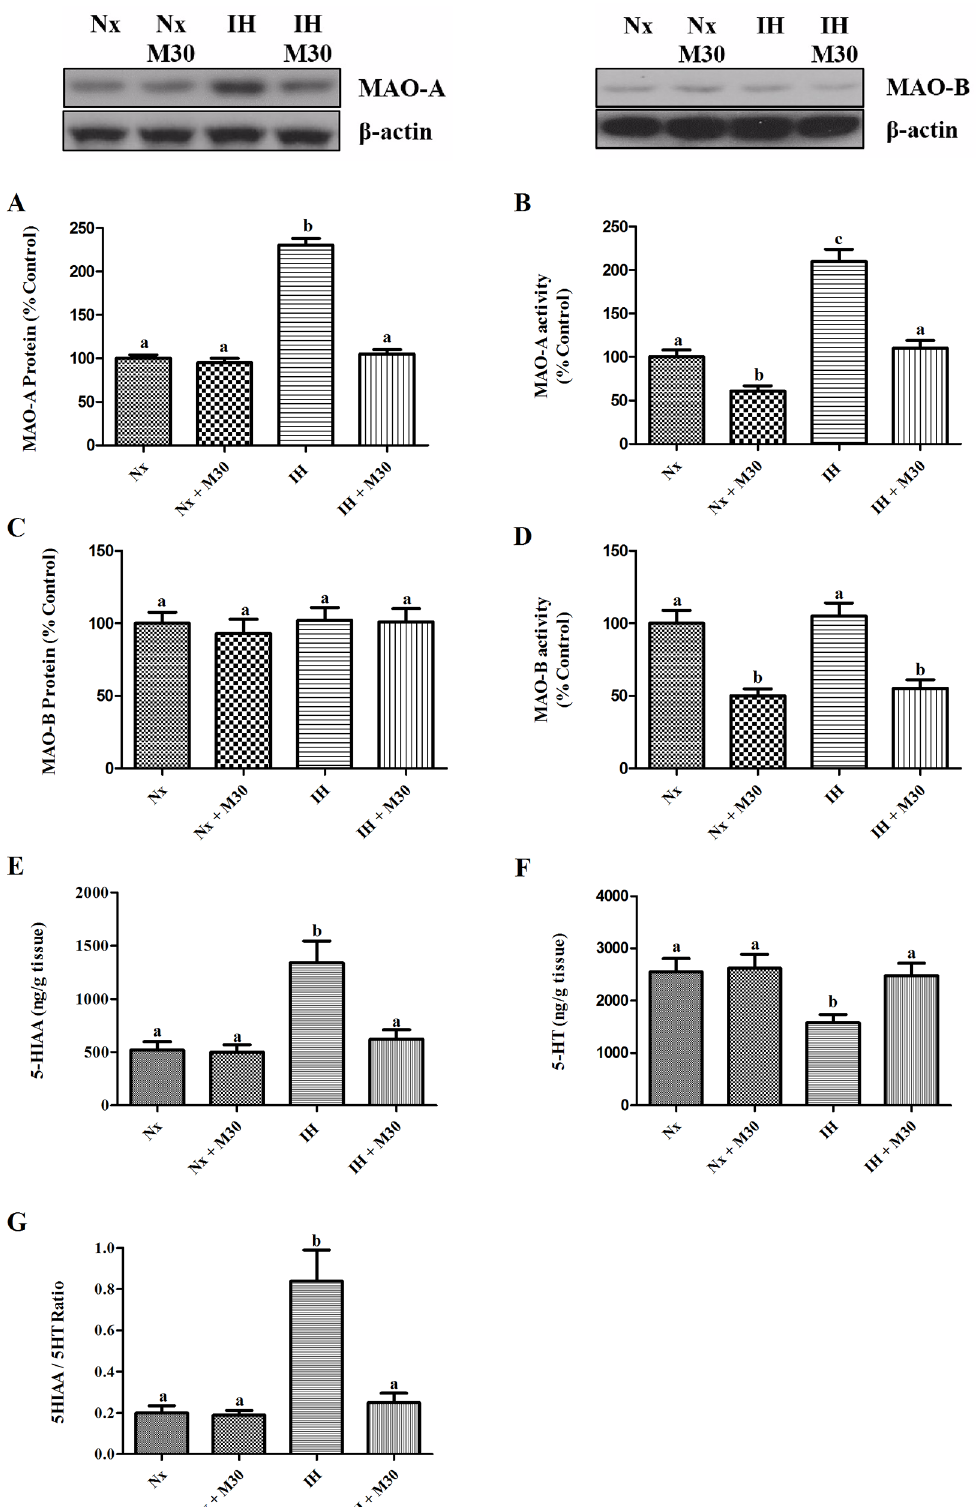
Fig 2. Hypoxia increasedthe metabolic turnover of serotonin mediated by the elevated activity of MAO-A but not MAO-B in the hippocampus. Serotonin(5-HT) level was also loweredin the hypoxic group. These